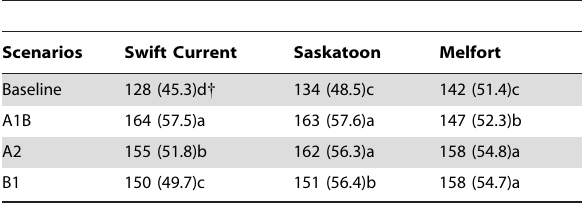
Table 5. Precipitation received during growth stage from seeding to early